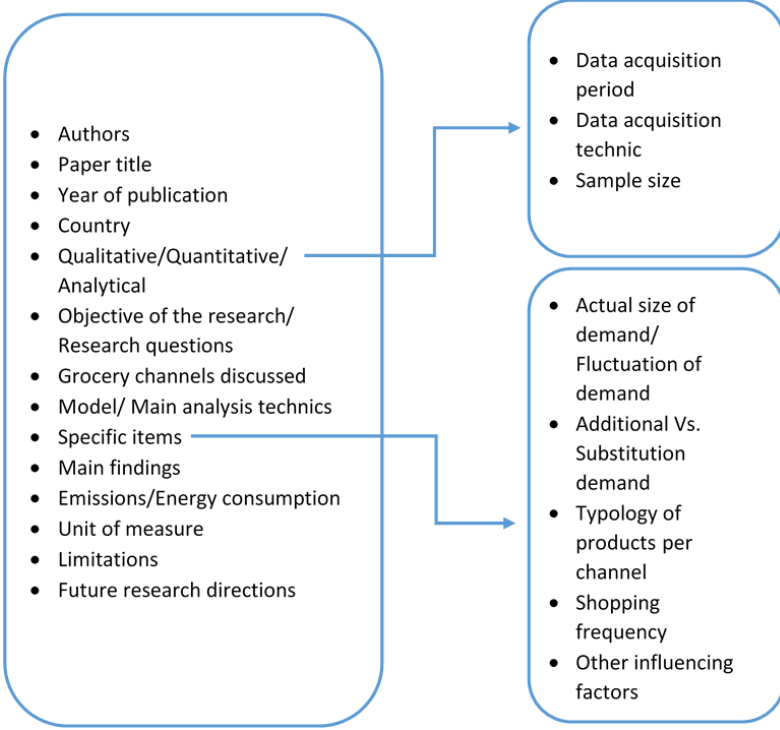
Figure 2. Data extraction form for the SLR. Source: Authors’